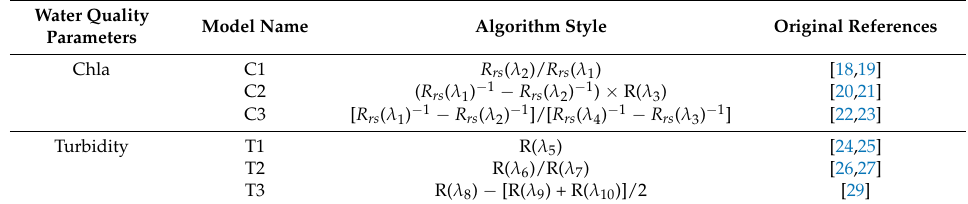
Table 2. Summary of standard chlorophyll a (Chla) and turbidity algorithms used in this study. C, chlorophyll; T,